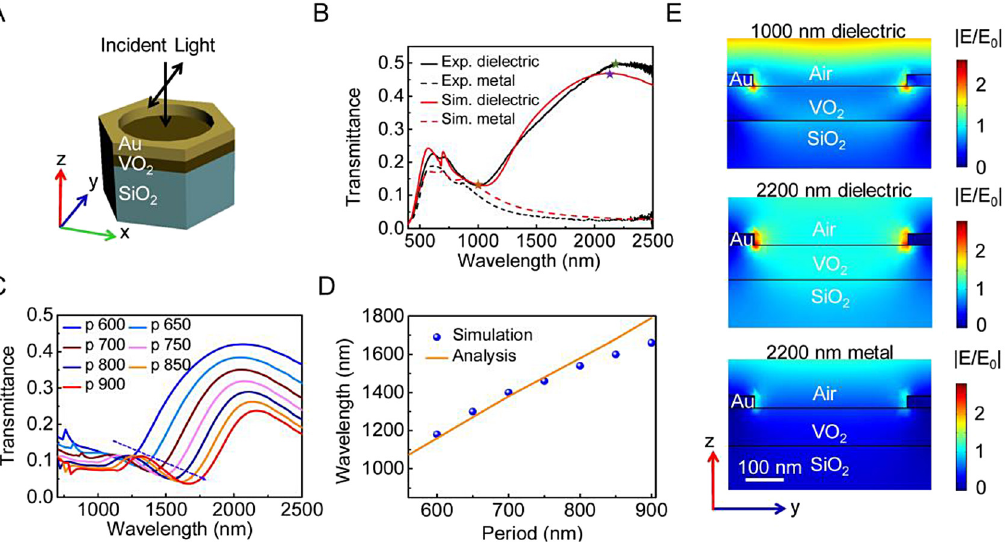
Figure 3: Far-field and near-field analysis of the metasurfaces. (A)Schematicoftheperiodicunitcellforoursimulation.(B)Simulatedandexperimentaltransmittancespectraatdielectricandmetallicstate. (C) Simulated transmittance spectra with period changing from 600 to 900 nm. (D) Resonant wavelength of SPR as a function of period for simulationandanalyticmethod.(E)Electric fi elddistributionsofanSPRmode,EOTatadielectricstateandEOTatametallicstatein y – z plane,